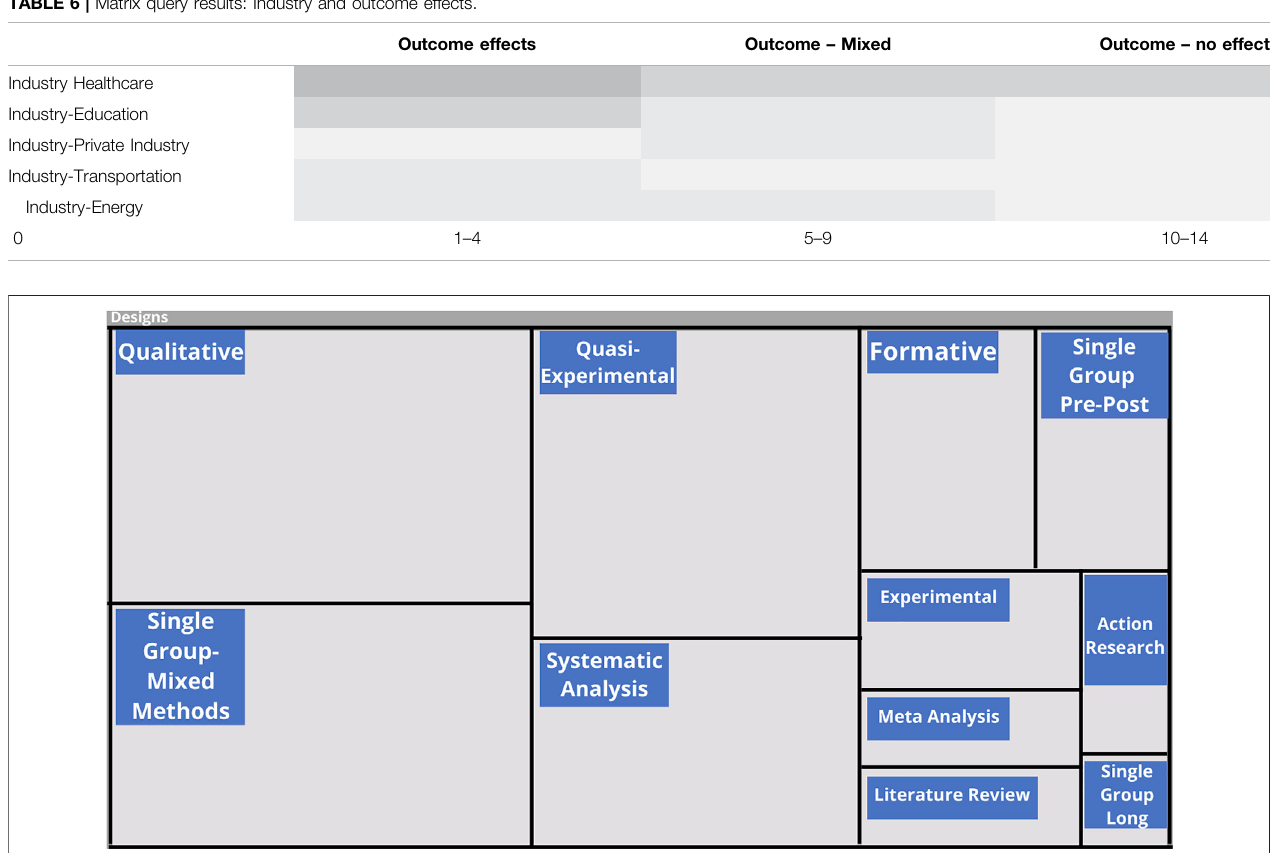
TABLE 6 | Matrix query results: Industry and outcome effects.